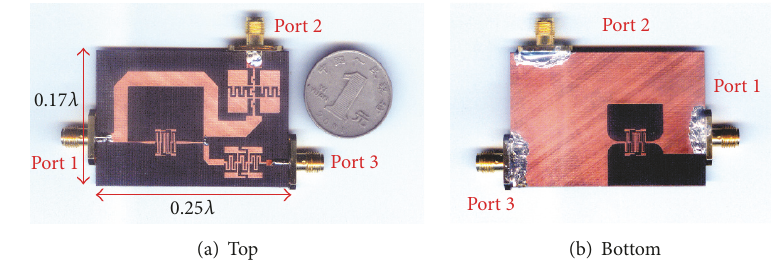
Figure 10: Photo of fabricated 4: 1 unequal power divider.